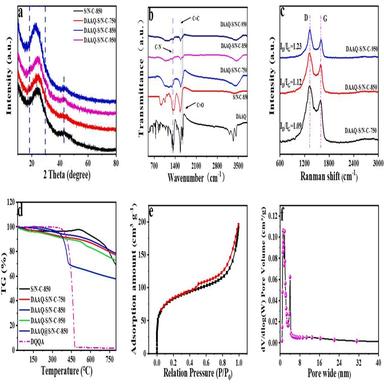
(a) XRD patterns, (b) FT-IR spectra of DAAQ S/N-C-850, and DAAQ-S/N-C samples. (c) Raman spectra of DAAQ-S/N-C samples. (d) TGA curves of DAAQ, S/ N-C-850, DAAQ@S/N-C-850, and DAAQ-S/N-C samples in a nitrogen atmosphere. (e) N2 adsorption-desorption isotherms of DAAQ-S/N-C-850 sample, and (f) its corresponding BJH pore size distribution curve.